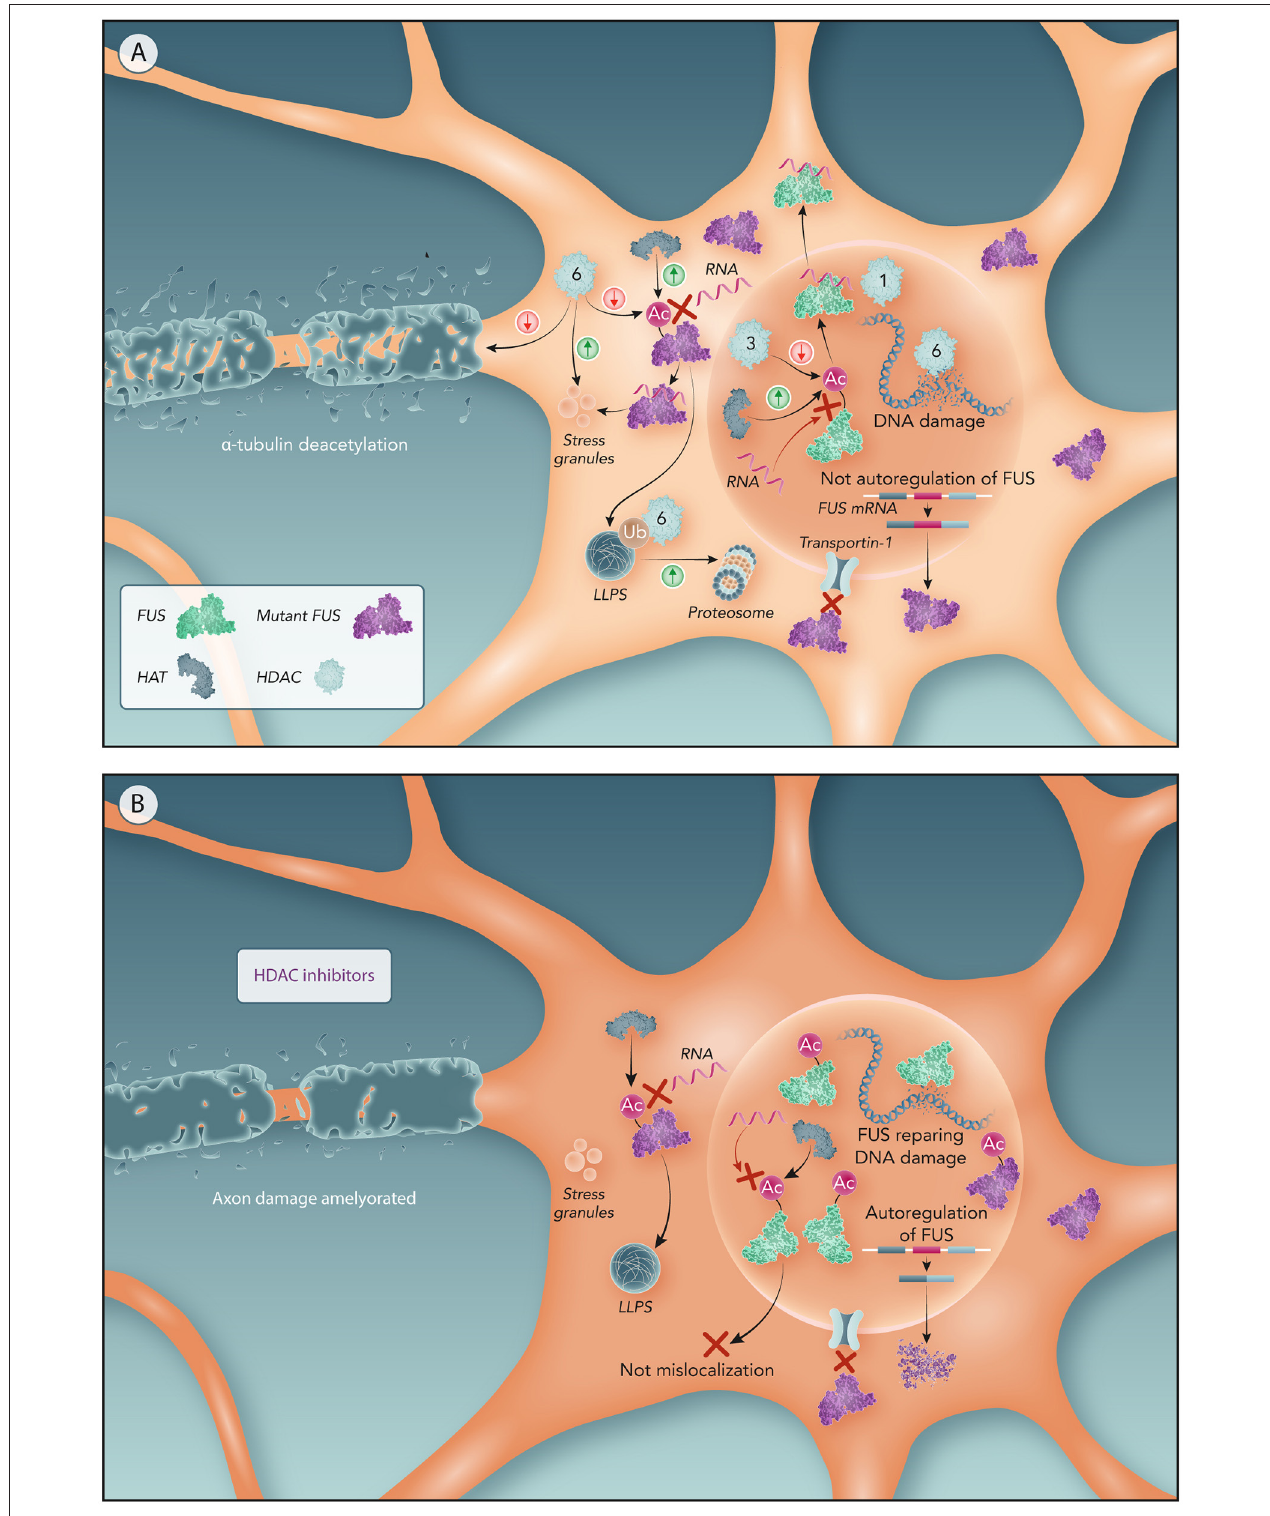
FIGURE 4 | Potential molecular mechanism of HDACs to drive FUS mislocalization and related ALS features. (A) Motor neurons with NLS-mutated FUS. Mutations in NLS domain impairs FUS binding to Transportin-1 resulting in FUS cytoplasm sequestration. Lower concentrations of nuclear FUS not activates FUS